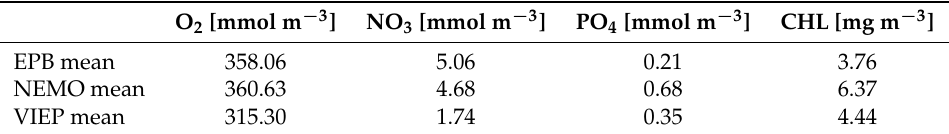
Table 5. Annual means of the selected